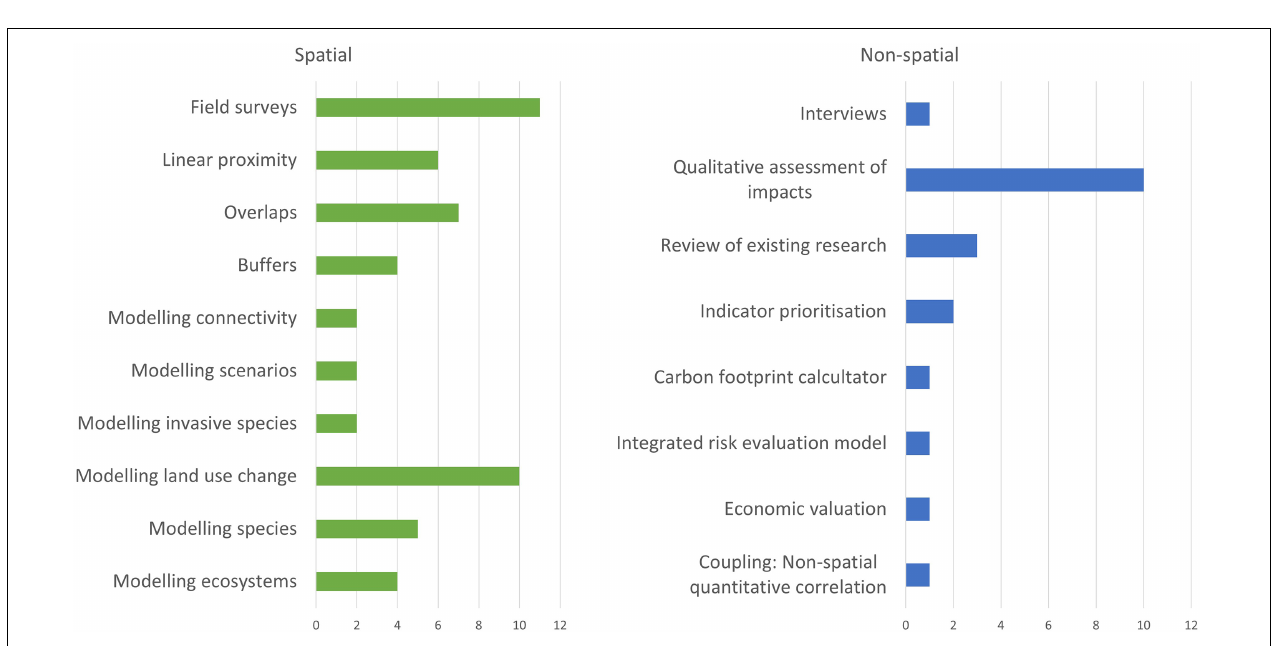
FIGURE 4 | All country case studies divided by: those not assessing impacts on biodiversity and ecosystem services (red); those assessing impacts on biodiversity and ecosystem services (orange); and those which in addition to assessing impacts and proposing biodiversity mitigation measures to manage those impacts (green). Total number of case studies are in brackets by the country